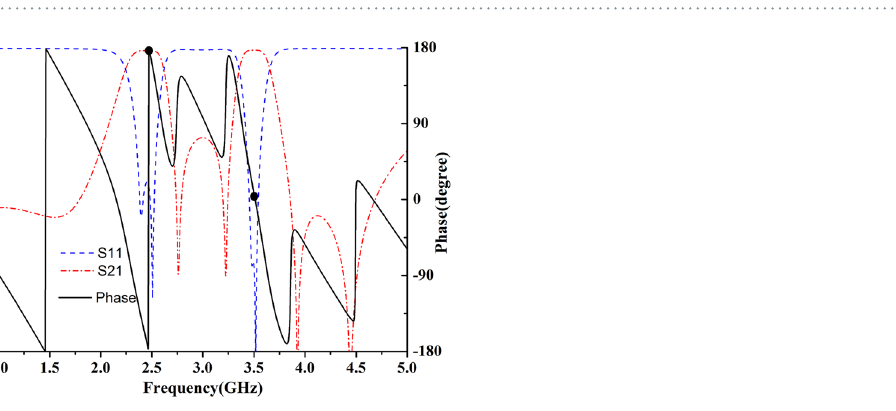
Figure 12. Simulated S-parameter of dual-band HMSIW filter before embed two dual-mode stub loaded resonator and phase between node A and node